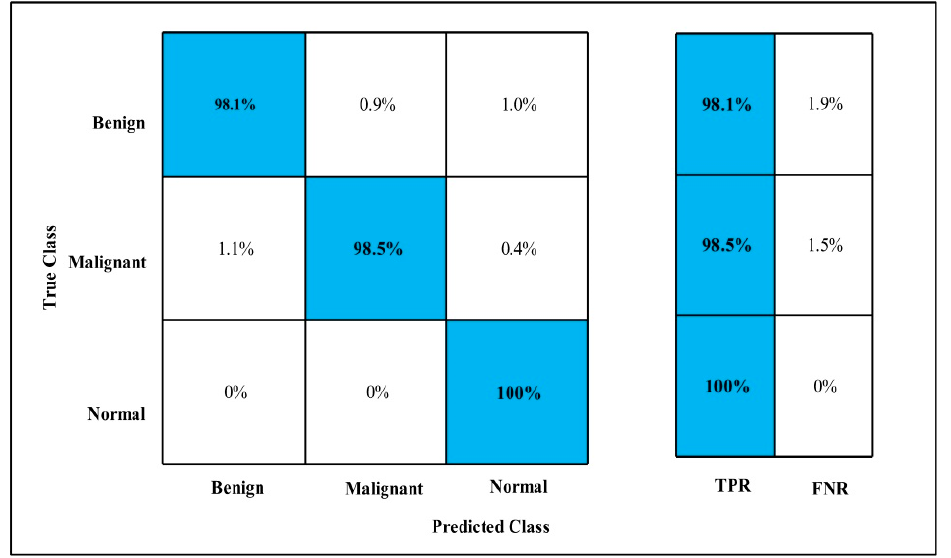
Figure 16. MEWOA on Fine-tuned MobilenetV2 TPR for MIAS. In Table 11, MEWOA on the Fine-tuned Nasnet model is applied to the MIAS dataset. The deep features are extracted from the GAP layer and fed to classifiers. The highest accuracy is 99.7%, which is achieved by the WKNN classifier in 24.70 (s). In this table, the minimum time is taken by Fine Tree, which is 9.40 (s), but the accuracy is 98.9%, which is less than that of WKNN. The second highest accuracy is achieved by Cubic SVM, which is 99.6% in 18.35 (s). Each classifier sensitivity rate is calculated and WKNN has the best value of 99%, which can be confirmed using the confusion matrix shown in Figure 17. Table 11. Classification results using MEWOA on Fine-tuned Nasnet deep features for MIAS.